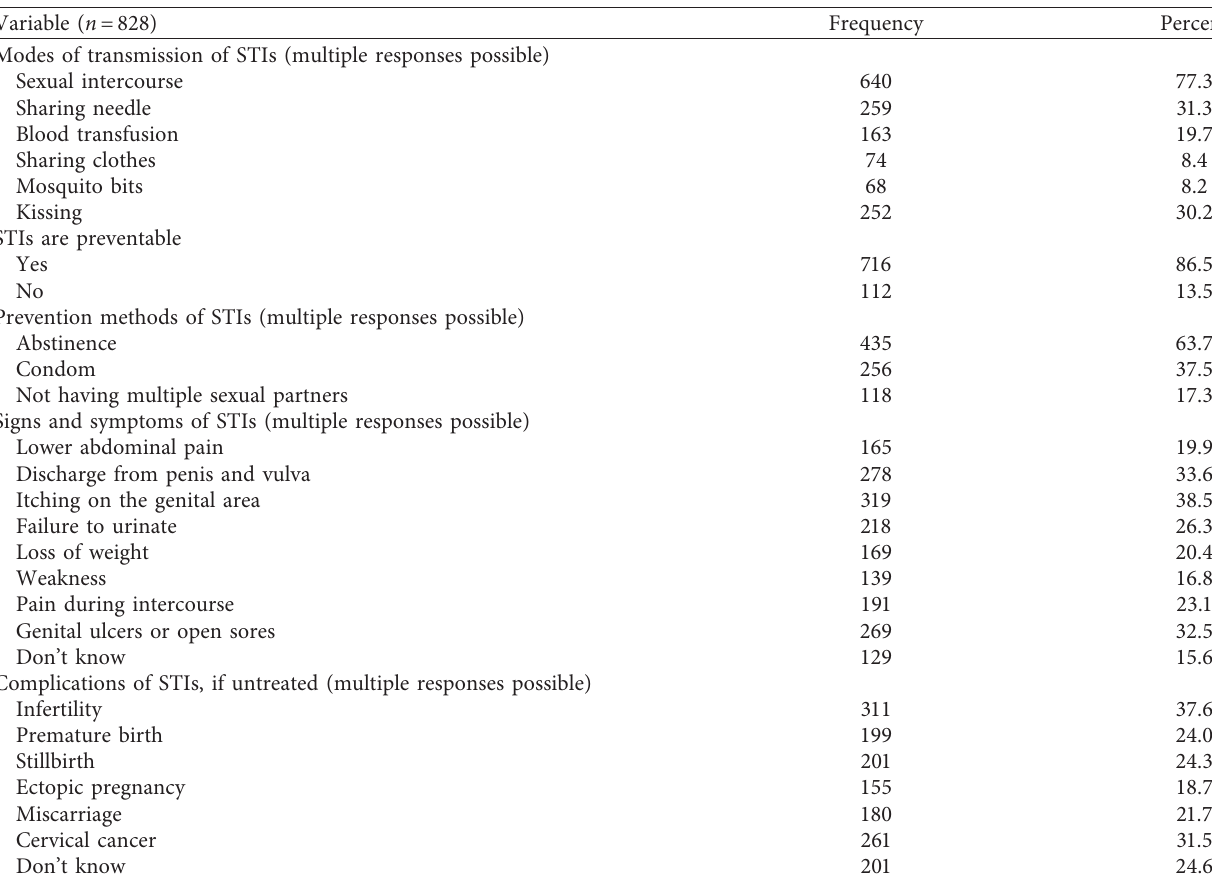
Table 2: Knowledge on the mode of transmission, prevention methods, signs, and symptoms and complication of STIs among preparatory school students in West Gojjam zone, Northwest Ethiopia, 2018. Variable ( n � 828) Modes of transmission of STIs (multiple responses possible)